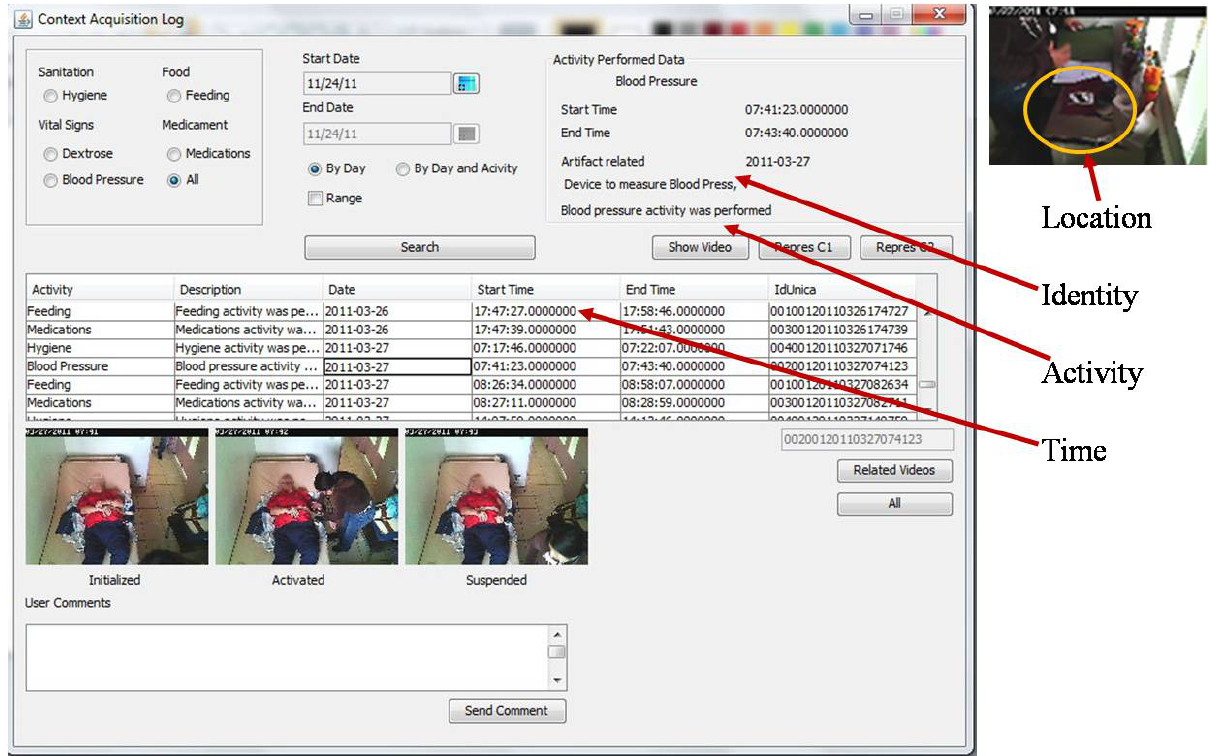
Figure 10. Recovering context through roaming